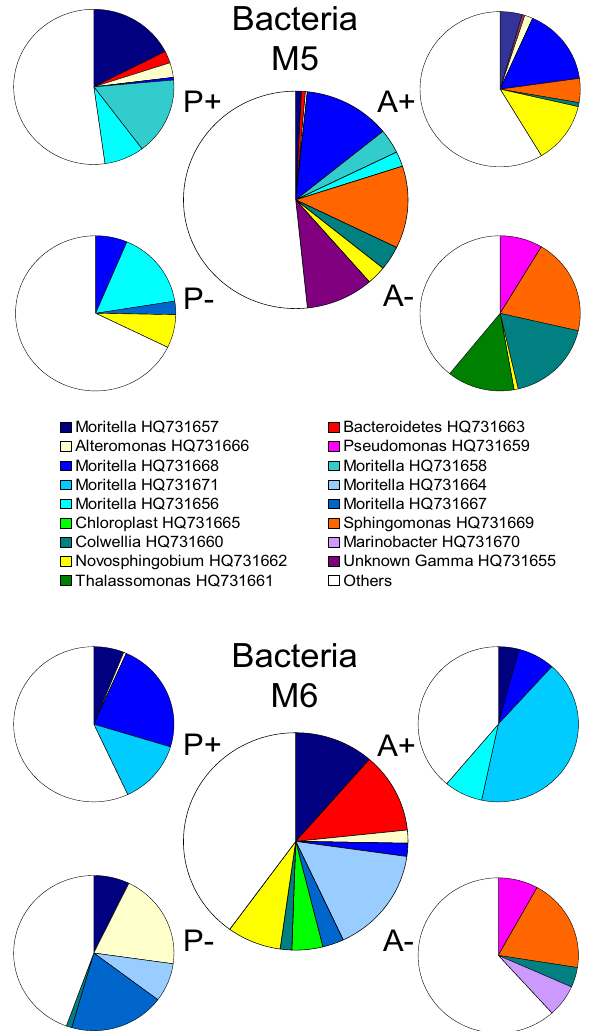
Figure 6. Changes in bacterial community structure in enrichment cultures. The percent contribution of sequenced DGGE bands to the total community. Relative abundance is derived from individual band intensities relative to the total sum intensity of all bands in the relevant lane. The large central pie represents the pre-incubation community. P+: 42 MPa with nutrient; P (cid:237)(cid:29)(cid:3)(cid:23)(cid:21)(cid:3)(cid:48)(cid:51)(cid:68)(cid:3)(cid:90)(cid:76)(cid:87)(cid:75)(cid:82)(cid:88)(cid:87)(cid:3)(cid:81)(cid:88)(cid:87)(cid:85)(cid:76)(cid:72)(cid:81)(cid:87)(cid:30)(cid:3)(cid:36)(cid:14)(cid:29)(cid:3)(cid:36)(cid:87)(cid:80)(cid:82)(cid:86)(cid:83)(cid:75)(cid:72)(cid:85)(cid:76)(cid:70)(cid:3)(cid:83)(cid:85)(cid:72)(cid:86)(cid:86)(cid:88)(cid:85)(cid:72)(cid:3)(cid:90)(cid:76)(cid:87)(cid:75)(cid:3)(cid:81)(cid:88)(cid:87)(cid:85)(cid:76)(cid:72)(cid:81)(cid:87)(cid:30)(cid:3)(cid:36)(cid:237)(cid:29)(cid:3) Atmospheric pressure without